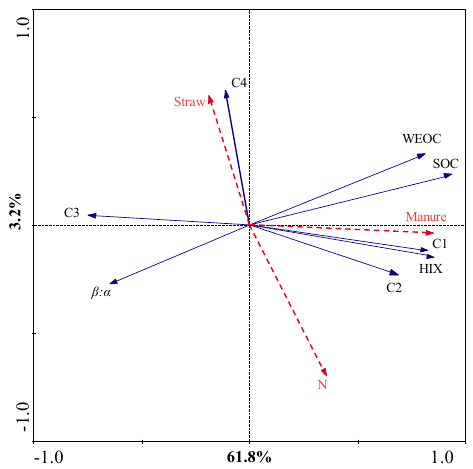
Figure 6. A redundancy analysis bi-plot showing correlations between soil carbon (C) and nitrogen (N) management practices and water-extractable organic matter characteristics. Red dotted arrows represent the C and N management practices (S = straw return, M = manure addition, N = N application); blue arrows represent the four components of dissolved organic matter (C1–C4) and the two fluorescence properties (HIX = humification index, β : α = the ratio of peak β to peak α ).